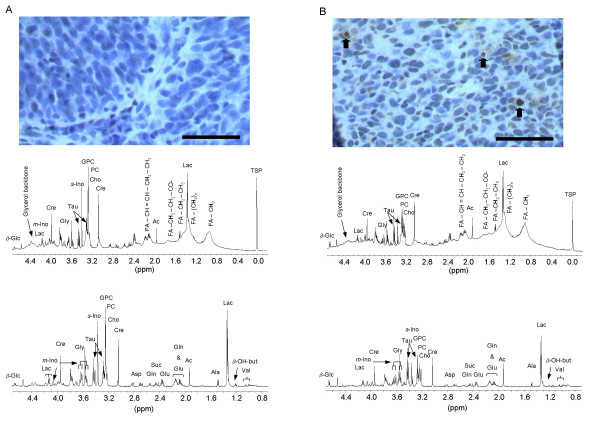
Histological section and HR MAS MR standard pulse-acquire spectrum (upper) and spin-echo spectrum (lower) of two cervical cancer biopsies, one with no apoptosis (A) and another with significant apoptotic activity (B). The histological sections were stained for apoptotic cells by use of the TUNEL method after spectrum acquisition. The biopsy presented in (A) had a tumor cell fraction of 85%, tumor cell density of 9552 cells/mm2, and no apoptosis, whereas the corresponding data of the biopsy in (B) were 35%, 3606 cells/mm2, and 8.3 apoptotic cells/mm2. Bars in the histological sections represent 50 μm, and arrows in (B) point to apoptotic cells. Note the highly preserved morphology of the samples after spectrum acquisition. Spectral assignments are abbreviated: β-Glc, β-glucose; Lac, lactate; m-Ino, myo-inositol; Cre, creatine; Gly, glycine; Tau, taurine; s-Ino, scyllo-inositol; GPC, glycerophosphocholine; PC, phosphocholine; Cho, choline; FA, fatty acids; TSP, trimethylsilyl propionic acid; Asp, aspartate; Gln, glutamine; Suc, succinate; Glu, glutamate; Ac, acetate; Ala, alanine; β-OH-but, β-hydroxybutyrate; Val, valine. The position of hydrogens in fatty acids giving rise to the different peaks is marked in bold after the notation FA in the upper spectra.